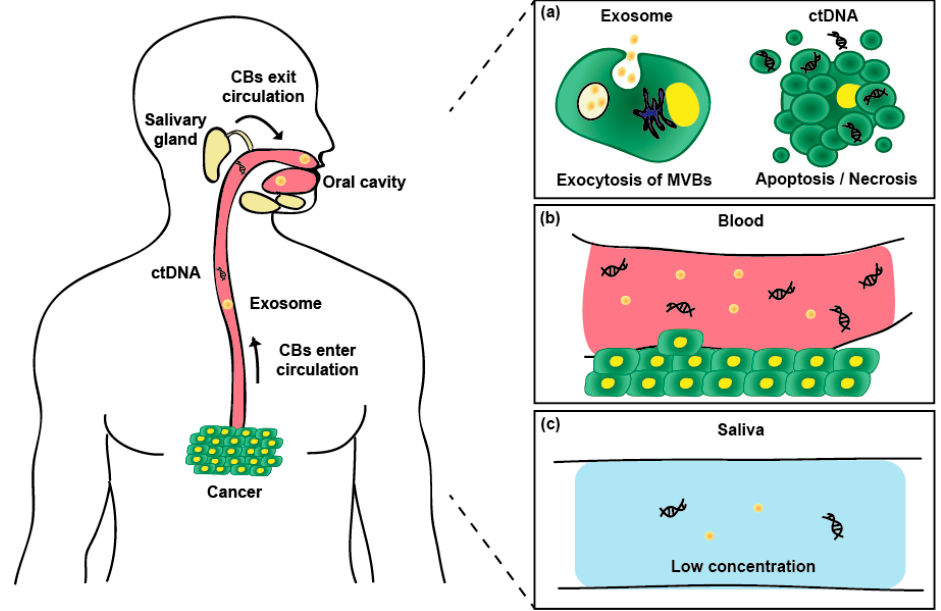
Figure 1. Generation and circulation of salivary circulating biomarkers (CBs). ( a ) Exosome and ctDNA are generated by exocytosis of multi-vesicular bodies (MVBs) and apoptosis and necrosis of cancer cells, respectively; ( b ) The produced biomarkers invade into blood vessels near the cancer tissue; ( c ) By circulating of body fluid, the biomarkers are present in saliva at low concentrations.